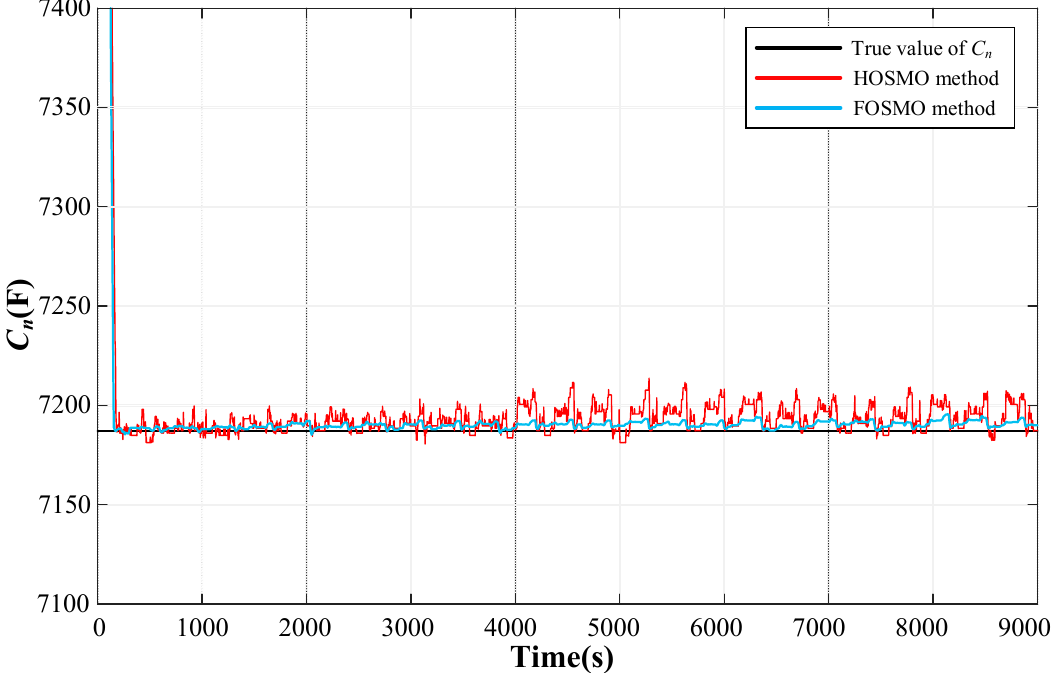
Figure 8. Comparison of C n estimated by FOSMO and HOSMO with the true value of C n.